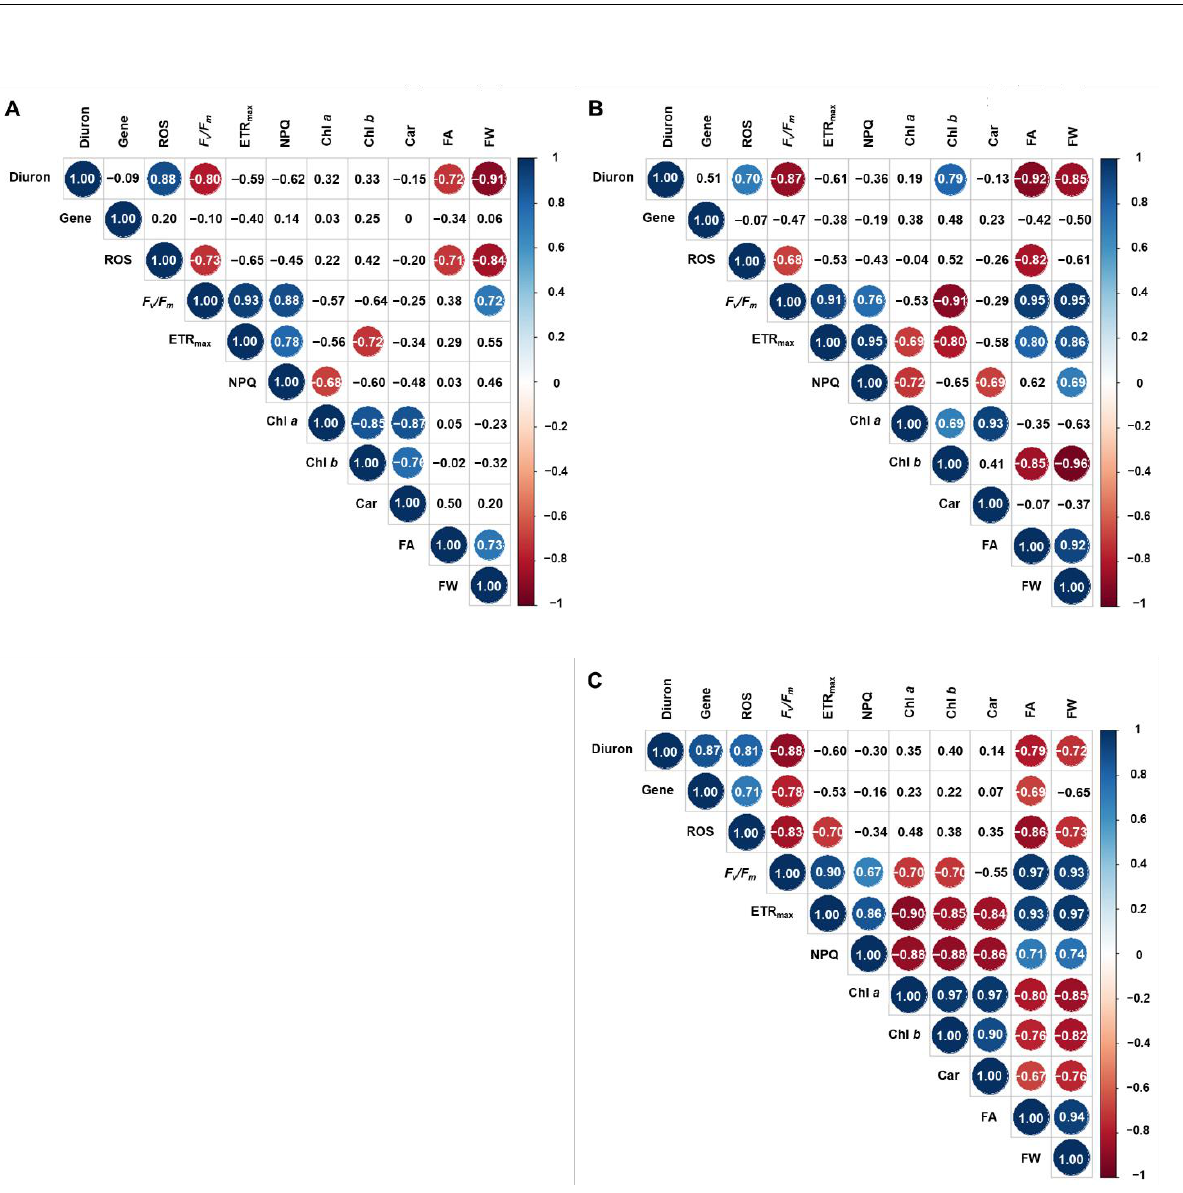
Figure 6. Correlation between 10 endpoints and diuron concentrations in L. minor at 24 ( A ), 48 ( B ), and 72 h of exposure ( C ). Only indicators showing statistical significance at the 5% level are shown in circles. The color and size of the circle indicate the strength of the correlation. The color bar on the right indicates the scale of the correlation coefficients. Light blue, blue, and navy blue indicate the correlation coefficients > 0.5, 0.7, and 0.9, respectively, while light pink, orange, and red indicate correlation coefficients < 0.5. The numbers in the boxes are the correlation coefficients. Note that for the sake of clarity, all correlation matrix views show only the upper part of the matrix to avoid duplication. Diuron, diuron concentration; FA, frond area; FW, fresh weight; Chl a , chlorophyll a content; Chl b , chlorophyll b content; Car, carotenoid content; F v /F m , maximum quantum yield; ETR max , the maximum electron transport rate; NPQ, non-photochemical quenching; ROS, reactive oxygen species production; Gene, relative rbcL gene expression.